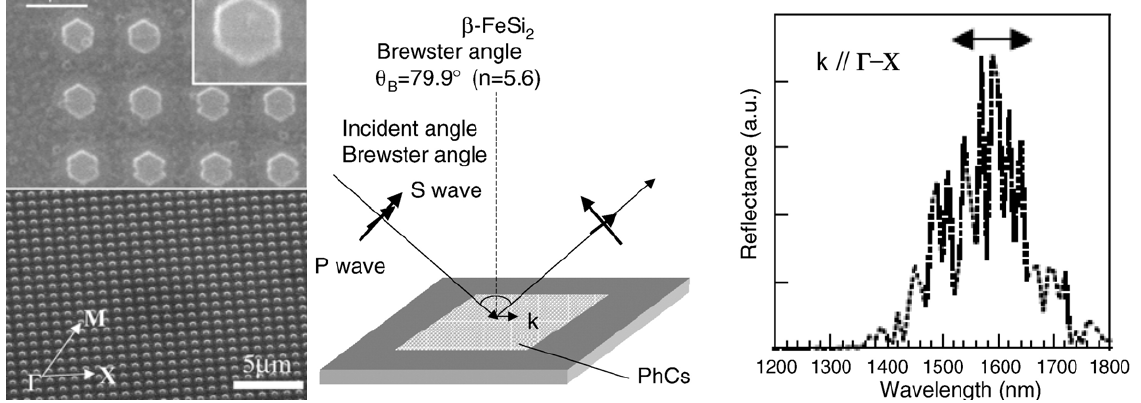
Figure 17. (Left) Square lattice photonic crystal with hexagonal columns of β -FeSi fabricated by an NLD-plasma etching process. (Right) Reflectance spectrum of polarized incident light at the Brewster angle. (Middle) A polarized light at the wavelength corresponding to the photonic band-gaps cannot propagate into the photonic crystal along any direction. Therefore, the reflectance becomes larger than the usual reflectance of the s- polarized light at the Brewster angle. Reproduced from Ref. [108] with permission from Elsevier